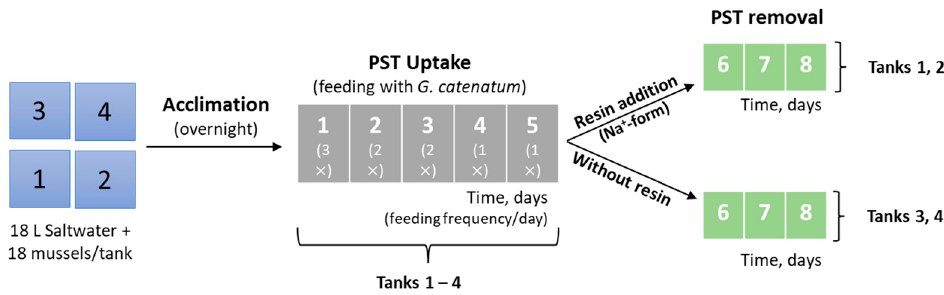
Figure 4. Experimental design for the feeding and clearance of live bivalves (third set of experiments). The numbers in the boxes on the left correspond to the tanks while the others (in the middle and on the right) correspond to the number of days.